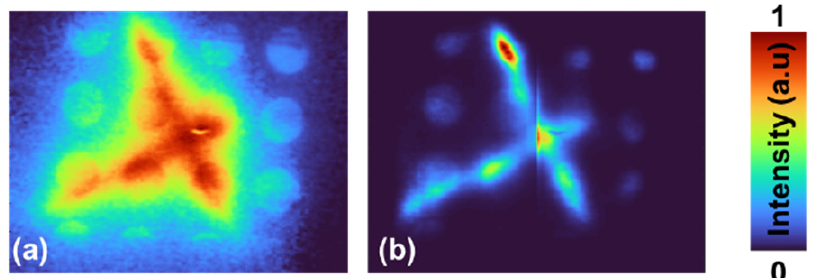
Figure 12. ( a ) Image of the recorded intensity distribution for a 4 mm thick object consisting of two thin objects—test object 2 and 3. ( b ) Reconstructed image using LRRA at the plane of the test object 2.